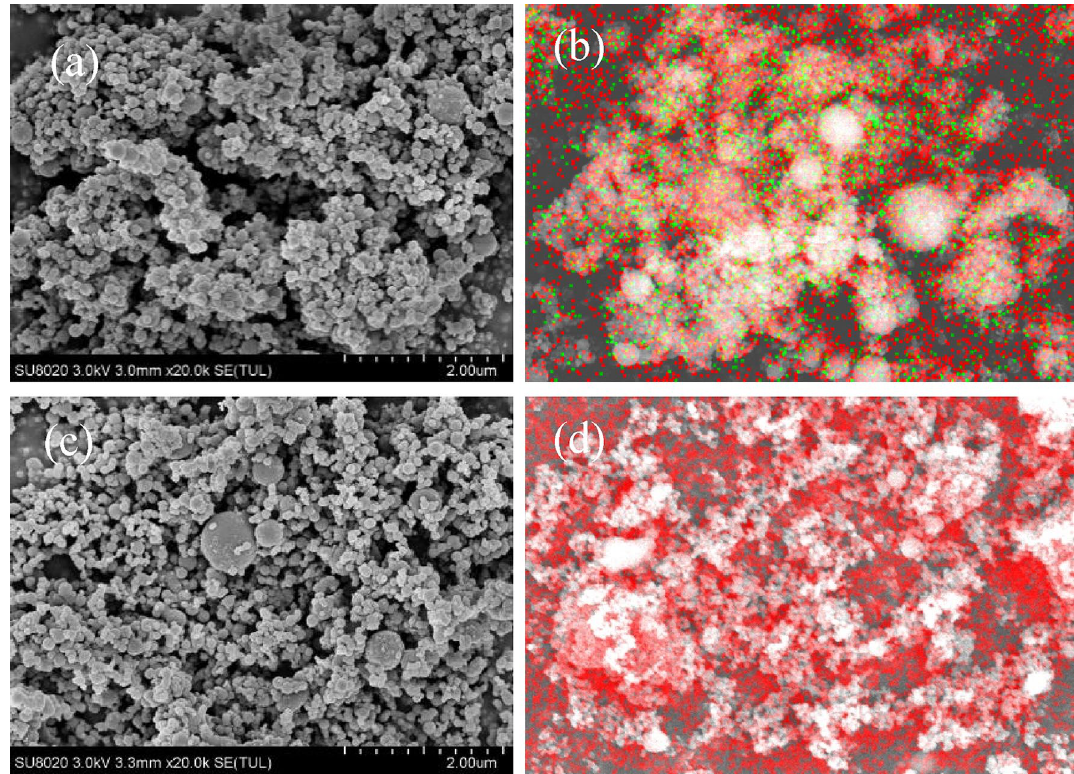
Figure 3. SEM and EDS photo of aluminum powder: ( a ) SEM photo of F2311 in situ coating aluminum powder; ( b ) EDS image of F2311 in situ coating; ( c ) SEM photo of raw aluminum powder; ( d ) EDS image of raw aluminum powder (green is F, red is